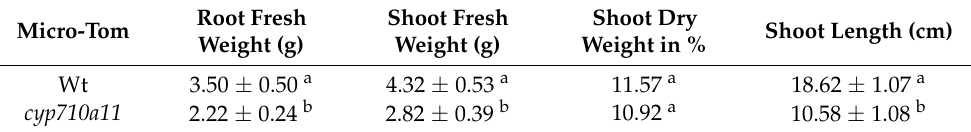
Table 1. Phenotypical data of the wt and the cyp710a11 knockout mutant of the tomato cv. Micro-Tom. Samples were taken from eight-week-old plants. The number of replicates was n = 6 for the wt plants and n = 5 for the mutant plants. Statistical significance was calculated using a two-tailed Student’s t -test. Means followed by the same letter within a column are not significantly different ( p < 0.05).